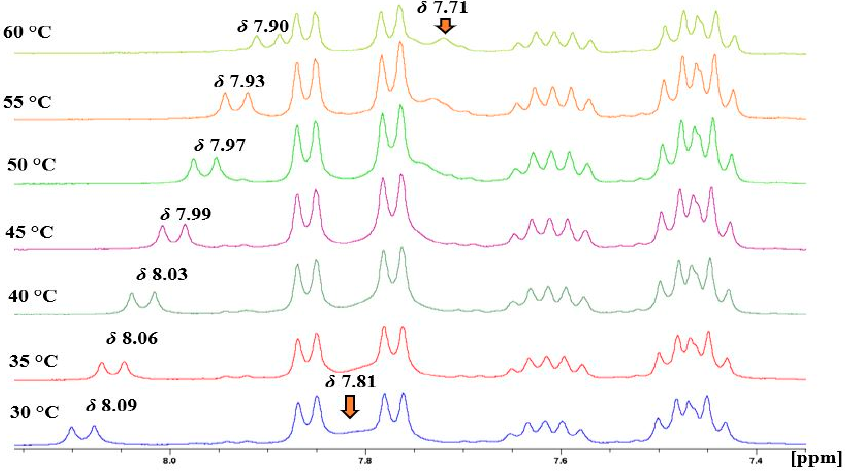
Figure 7. Stacked 1 H NMR spectra of DM35 complex with CuSO 4 ∙ 5H 2 O at different temperatures. The signal for triazole and amides are labeled.